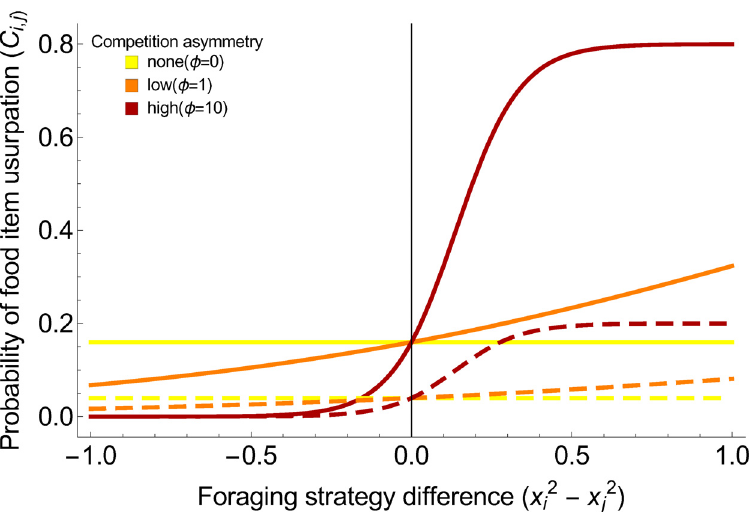
Fig 3. Probability that a colony of species i usurps a food item controlled by a colony of species j based on the difference in the squared values of their degree of collective foraging ( x 2 in which there is no competitive asymmetry ( ϕ = 0), the orange lines represent situations of low competitive asymmetry ( ϕ = 1), and the dark red lines represent situations of high competitive asymmetry ( ϕ = 10). The dashed lines represent situations in which food items are large and scarce ( ρ = 0.2), while undashed lines represent situations in which food items are small and abundant ( ρ = 0.8).